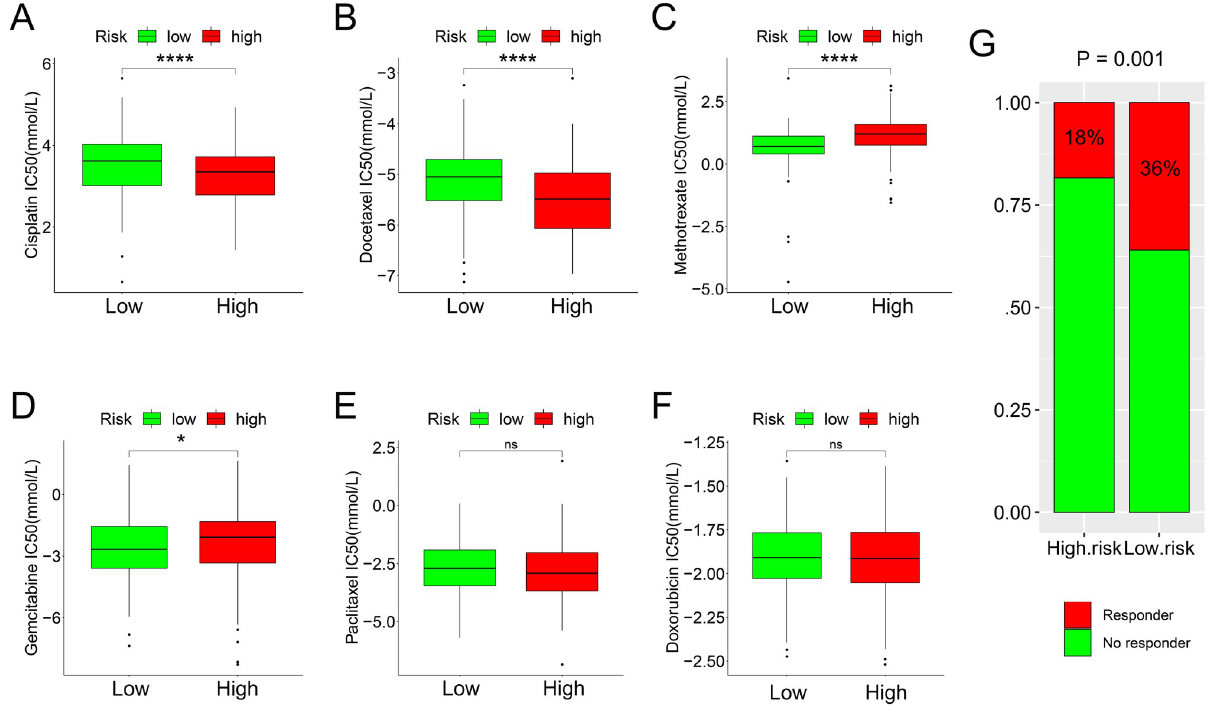
Fig 10. Risk score and drug sensitivity. Cisplatin (A) and docetaxel (B) exhibited higher IC50 values in low-risk patients; thus, the high-risk group was more sensitive to cisplatin and docetaxel. Methotrexate (C) and gemcitabine (D) exhibited a higher IC50 in high-risk BC patients; thus, low-risk BC patients were more sensitive to methotrexate and gemcitabine. However, there were no significant differences between other chemotherapy drugs (paclitaxel and doxorubicin) and the risk score (E-F). The CR/PR rate in low-risk patients was higher than that in high-risk patients (G), indicating more significant immunotherapy benefits for low-risk patients. IC50, half-maximal inhibitory concentration; SD, stable disease; PD, progressive disease; CR, complete response; PR, partial response; BC, bladder cancer; � , P < 0.05; ���� , P < 0.0001.